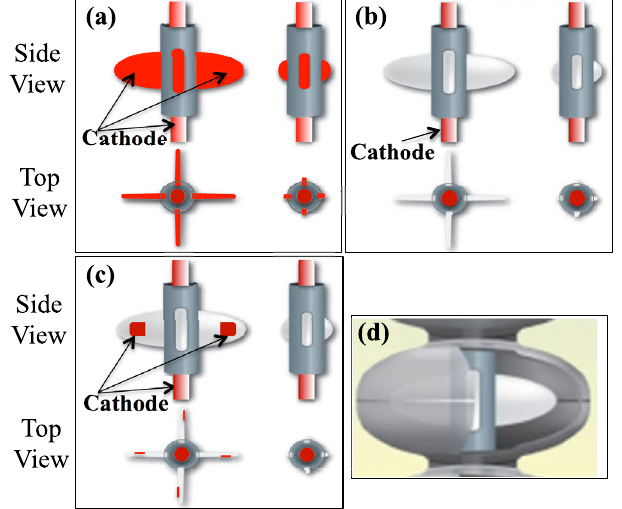
agitation.FIG. 2. Schematics of (a) NC-1 with Al blades, (b) NC-2 with insulating blades, and (c) NC-3 with partial metallic blades. (d) Ninja cathode inside a cavity cell. Red color in the figures represents Al cathode whereas white and grey colors indicate the insulating